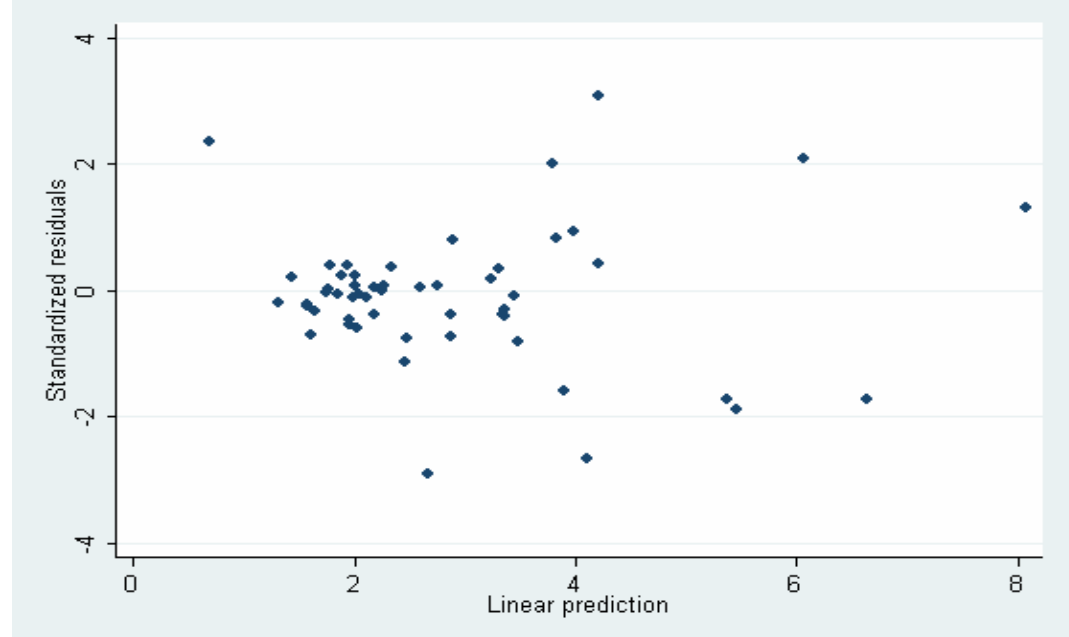
Fig. 2. Plot of standardized residuals versus predicted value (relative version, model 2, eq. (10a))